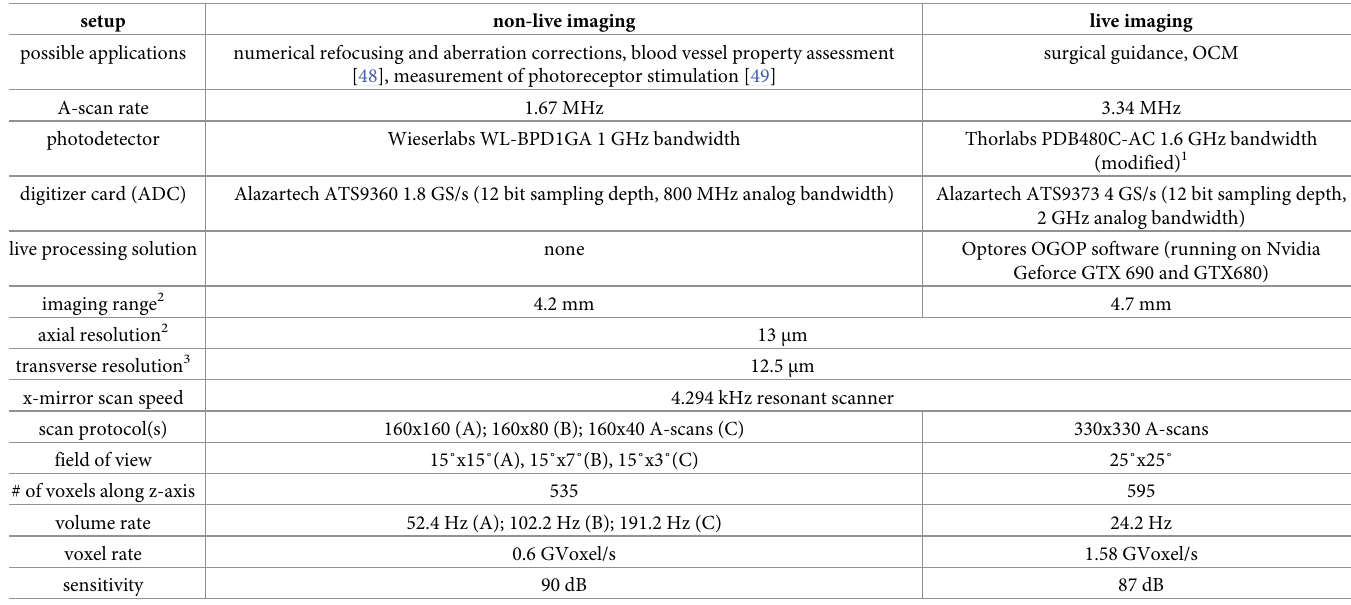
Table 1. Imaging